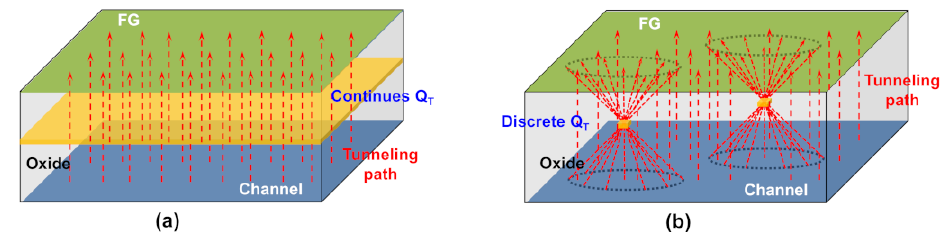
Figure 2. Schematic diagrams of all the possible tunneling paths by the ( a ) continuous and ( b ) discrete Q T during P/E